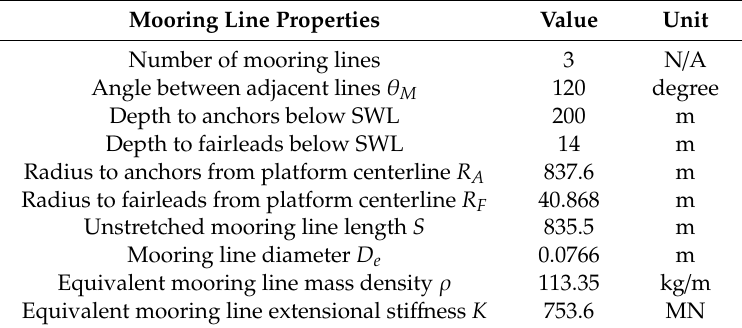
Figure 6. The mooring layout in θ = 0 ◦ , 30 ◦ , 60 ◦ , and 90 ◦ wave heading angles. Table 2. Mooring line properties [11] .